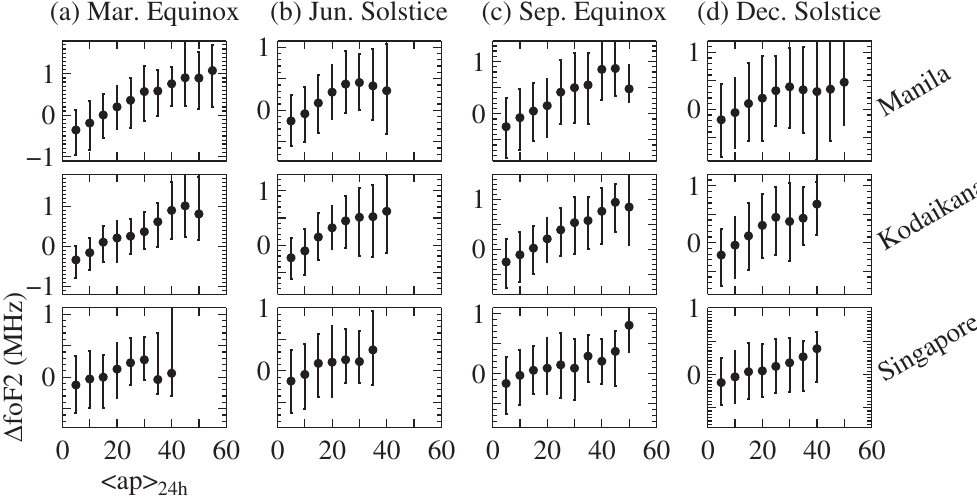
Fig. 6. Same as Figure 4 but for the equatorial stations (from top to bottom: Manila, Kodaikanal, and Singapore).